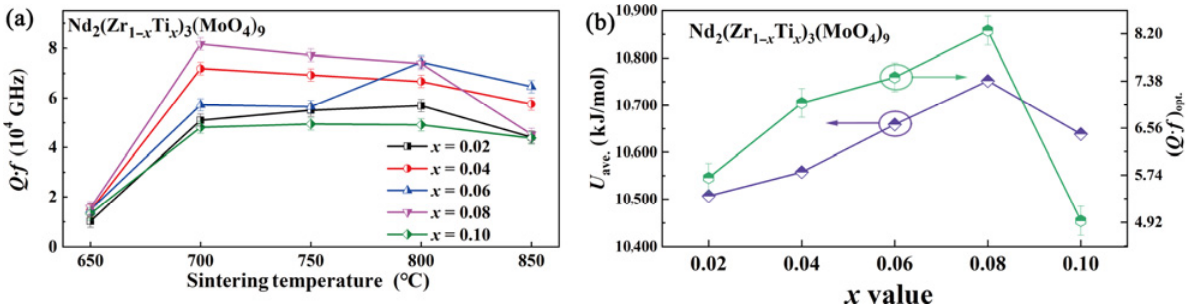
Fig. 9 (a) Q·f and (b) optimal quality factors (( Q·f ) opt. ) and average lattice energy ( U ave. ) of NZ 1 − x T x M ( x = 0.02–0.10) ceramics sintered at 650–850 .